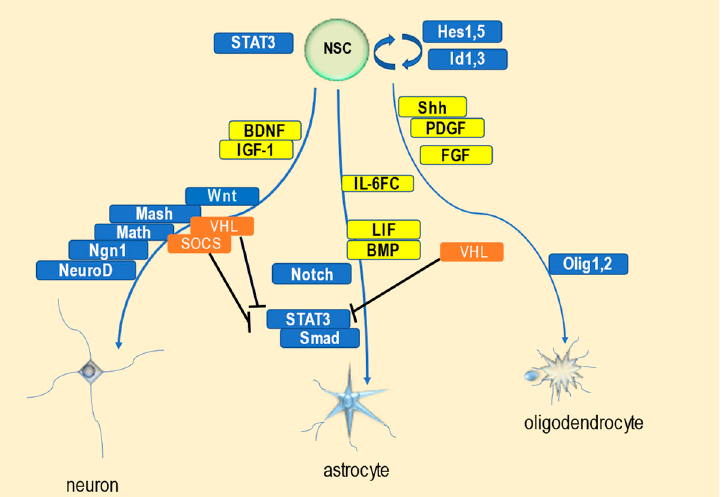
Figure 1. Molecular differentiation pathways of neural stem cells (NSCs). NSCs are maintained by HES1 and 5, ID1 and 3, and the signal transduction and activator of transcription 3 (STAT3). Neuronal differentiation is induced by extracellular factors, such as platelet-derived growth factor (PDGF), brain-derived neurotrophic factor (BDNF), and insulin-like growth factor-1 (IGF-1), and intracellular factors, such as Wnt, Mash, Math, neurogenin1 (Ngn1), von Hippel-Lindau (VHL), and suppressor of cytokine signaling (SOCS). Astrocytic differentiation is induced by extracellular fac- tors, such as interleukin-6 family cytokines (IL-6FCs), leukemia inhibitory factor (LIF), and bone morphogenetic protein (BMP), and intracellular factors, such as Notch, STAT3, and small mother against decapentaplegic (Smad). Oligodendrocytic differentiation is induced by extracellular fac- tors, such as Sonic Hedgehog (Shh), PDGF, fibroblast growth factor (FGF), and bone morphogenetic protein (BMP), and intracellular factors, such as VHL and Olig1 and 2. SOCS and VHL inhibit STAT3 through the Janus kinase–signal transduction and activator of transcription (JAK-STAT) pathway [2–12]. 2. Structure of SOCS and VHL Proteins SOCS (CIS and SOCS 1–7) and VHL form the Elongin B/C–Cul2/Cul5–SOCS-box pro- tein (ECS) complex, a member of the ubiquitin ligase family that shares a Cullin-Rbx mod- ule. SOCS and VHL bind Cullin-Rbx via BC-box-binding Elongin C; however, VHL lacks the C-terminal sequence of the SOCS box (downstream of the BC box). In mammalian cells, SOCSs bind to Cul5-Rbx2; in contrast, VHL specifically interacts with endogenous Cul2-Rbx1. Therefore, the ECS complex has two distinct protein assemblies: one contain- ing a subunit with a VHL box (composed of a BC box and a downstream Cul2 box) that interacts with Cul2–Rbx1 and the other containing a subunit with a SOCS box (composed of a BC box and a downstream Cul5 box). Domain exchange analyses demonstrated that the specificity of the interaction of VHL-box and SOCS-box proteins with the Cullin-Rbx module was conferred by Cul2 and Cul5 boxes, respectively. Additionally, the RNAi-me- diated knockdown of Cul2–Rbx1 inhibited the VHL-mediated degradation of HIF-2 α , whereas Cul5–Rbx2 knockdown did not affect the function of the Cul2–Rbx1 and Cul5– Rbx2 modules [13] (Figure 2).